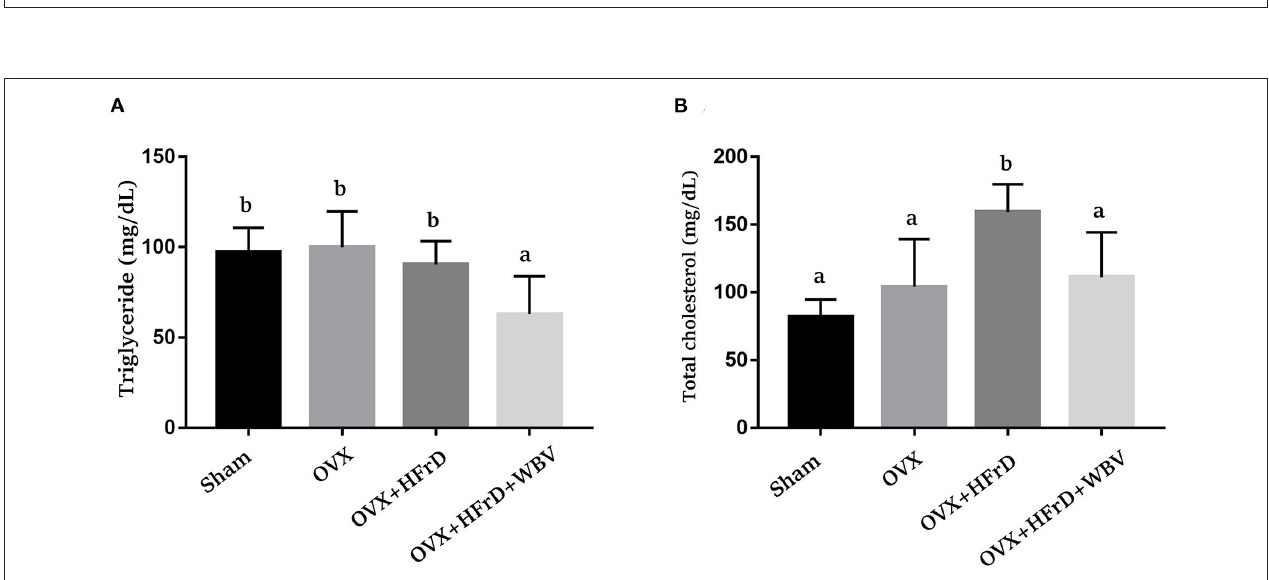
FIGURE 4 | The effects of whole-body vibration (WBV) combined with a high-fructose diet (HFrD) on ovariectomized (OVX) mice in terms of HFrD-induced hyperlipidemia indices. The triglyceride (TG) (A) and total cholesterol (TC) (B) hyperlipidemia indices were assessed at the end of the study. The data are presented as means ± SD. Different superscript letters indicate significant differences ( P < 0.05), as indicated by a one-way analysis of variance.